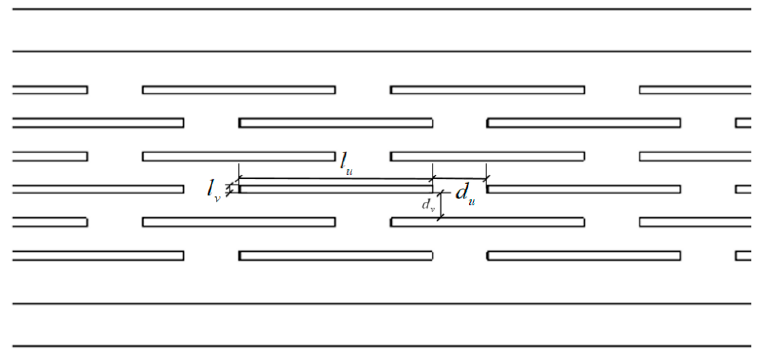
Figure 9. The layout of web openings of C light-gauge steel.